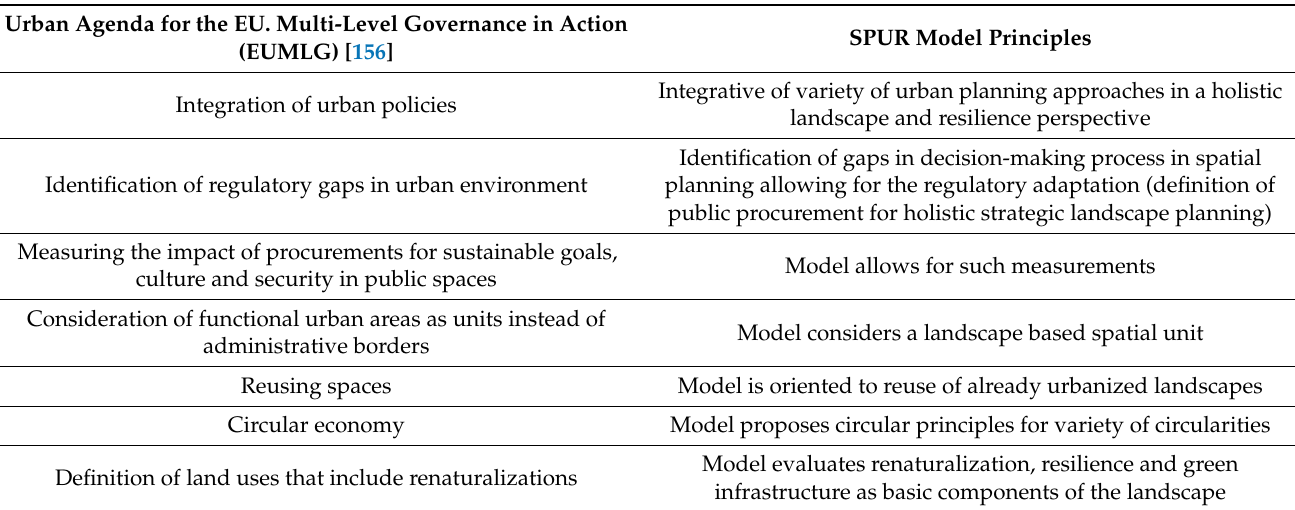
Table 6. Comparison of EUMLG topics with SPUR model